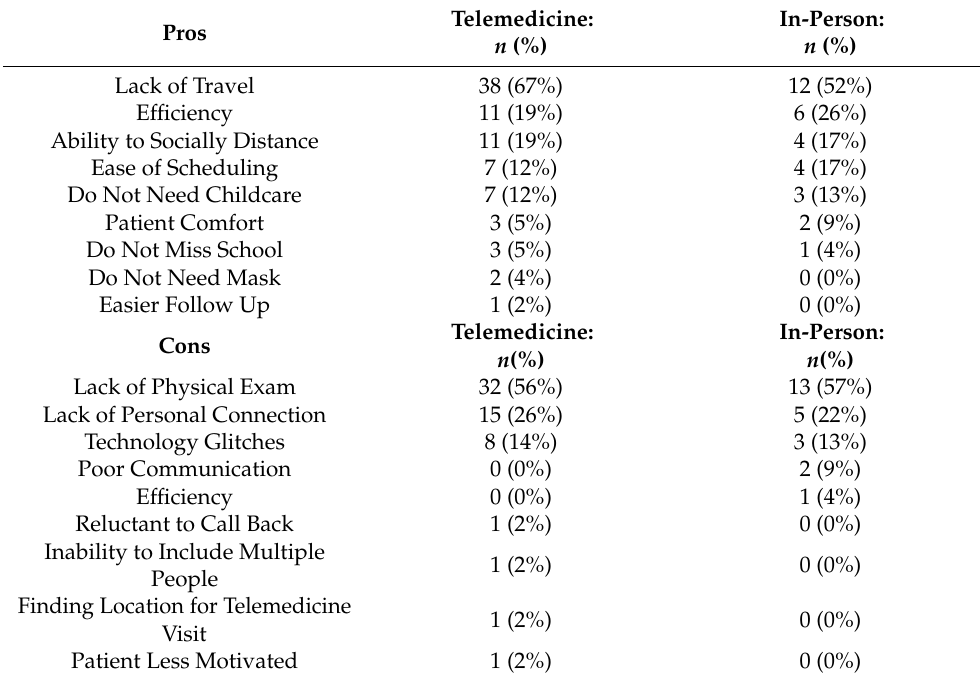
Table 2. Pros and cons of virtual visits as noted by caregivers in the 6-month follow-up